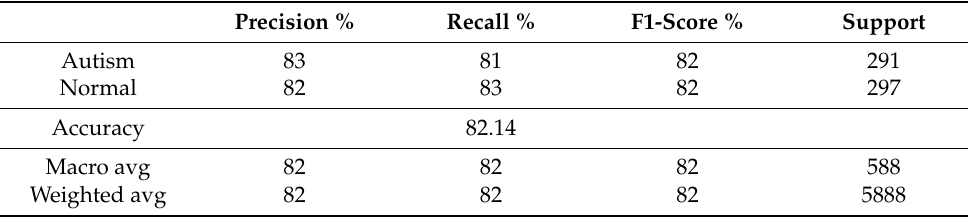
Table 3. Results of VGG-16 with logistic regression. Precision % Recall % F1-Score %